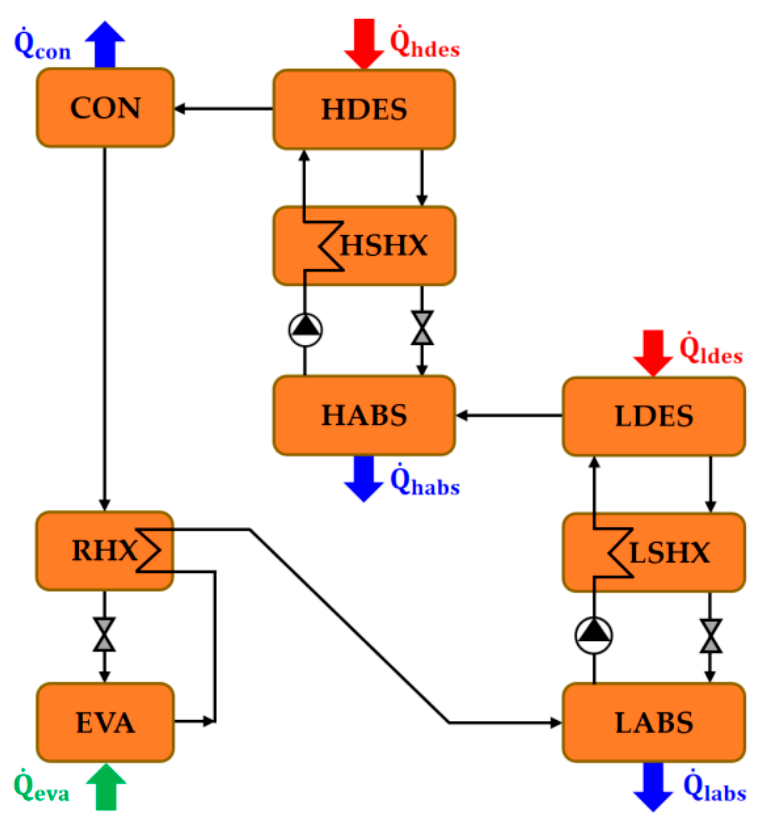
Figure 17. Double ‐ lift (half ‐ effect) ammonia/water absorption cycle of the University of Innsbruck Figure 17. Double-lift (half-effect) ammonia / water absorption cycle of the University of Innsbruck prototype. Adapted from Reference [77]. Note: CON=condenser; EVA=evaporator; HABS=high ‐ prototype. Adapted from Reference [77]. Note: CON = condenser; EVA = evaporator; temperature absorber; HDES=high ‐ temperature desorber; HSHX=high ‐ temperature solution heat HABS = high-temperature absorber; HDES = high-temperature desorber; HSHX = high-temperature exchanger; LABS=low ‐ temperature absorber; LDES=low ‐ temperature desorber; LSHX=low ‐ solution heat exchanger; LABS = low-temperature absorber; LDES = low-temperature desorber; temperature solution heat exchanger; RHX=refrigerant heat exchanger. LSHX = low-temperature solution heat exchanger; RHX = refrigerant heat